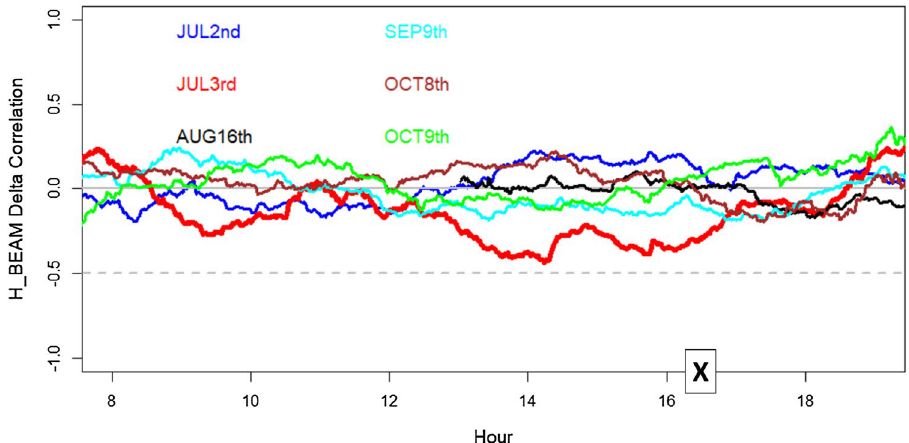
Figure 14. Correlation between the angular opening of BS cells (in relation to cell azimuth) including 68% of users (standard deviation of the distribution) related to Sun exposed BS cells and the angular opening of BS cells (in relation to cell azimuth) of not Sun exposed BS cells, using a sliding window of 180 min (at each minute the correlation value is attributed to the centre of the 180 min period), between sunrise and sunset. The “X” indicates the flare peak in X-ray emission (local Italian time, UT + 2H) related to the 3rd of July case.